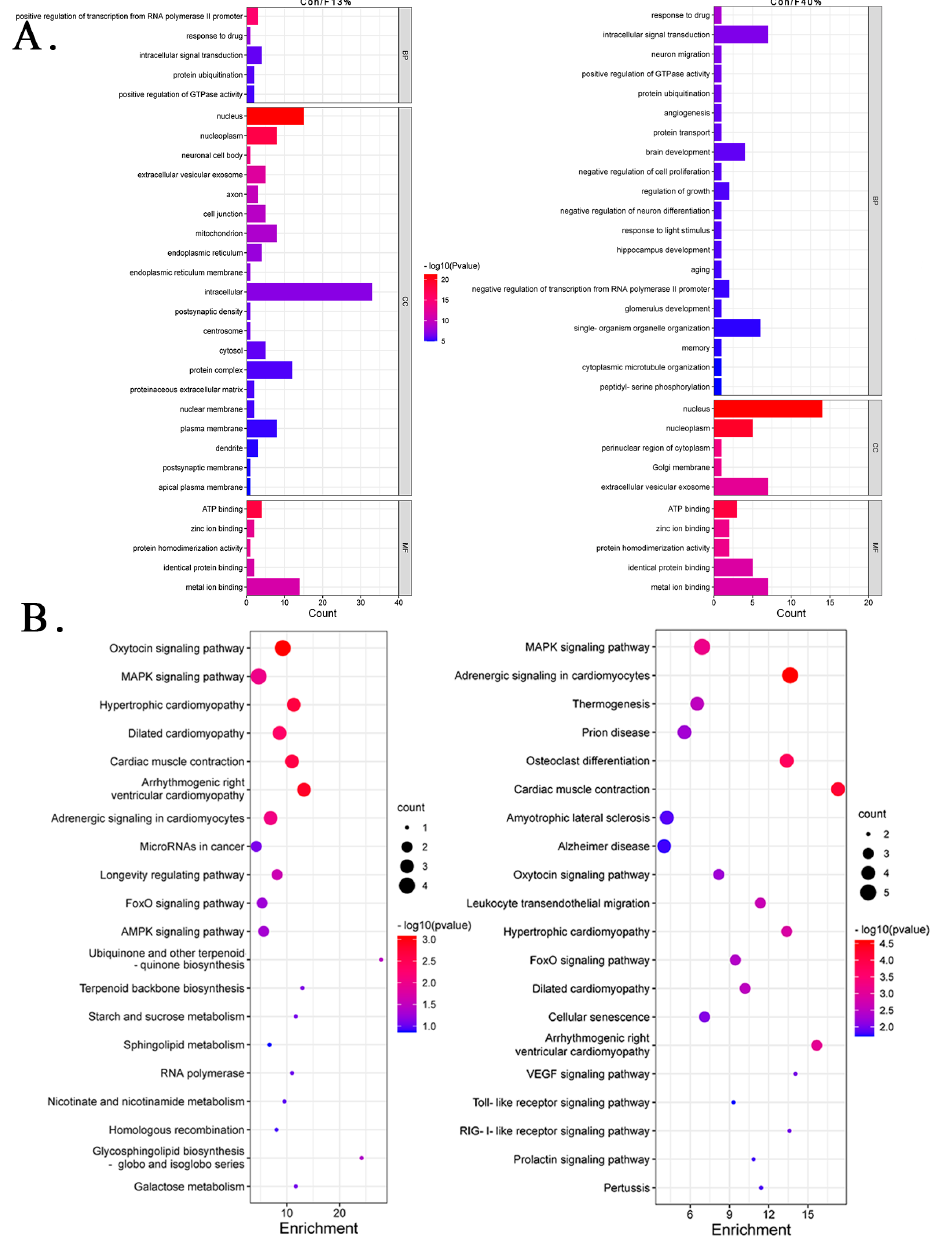
Figure 5. GO and KEGG enrichment analysis based on differentially expressed lncRNA (DElncRNA) target genes. ( A ) The top 20 GO enrichment analysis results of Con/F13% and Con/F40%. The ordinate represents the name of GO terms; the abscissa represents the gene count; and the color indicates the − log10 ( p -value) of GO terms. ( B ) The top 20 KEGG pathway enrichment analysis results of Con/F13% and Con/F40%. Each circle represents a KEGG pathway; the ordinate represents the pathway name; the abscissa represents enrichment factor; the circle color indicates the p -value; and the circle size indicates the number of enriched genes in the pathway.